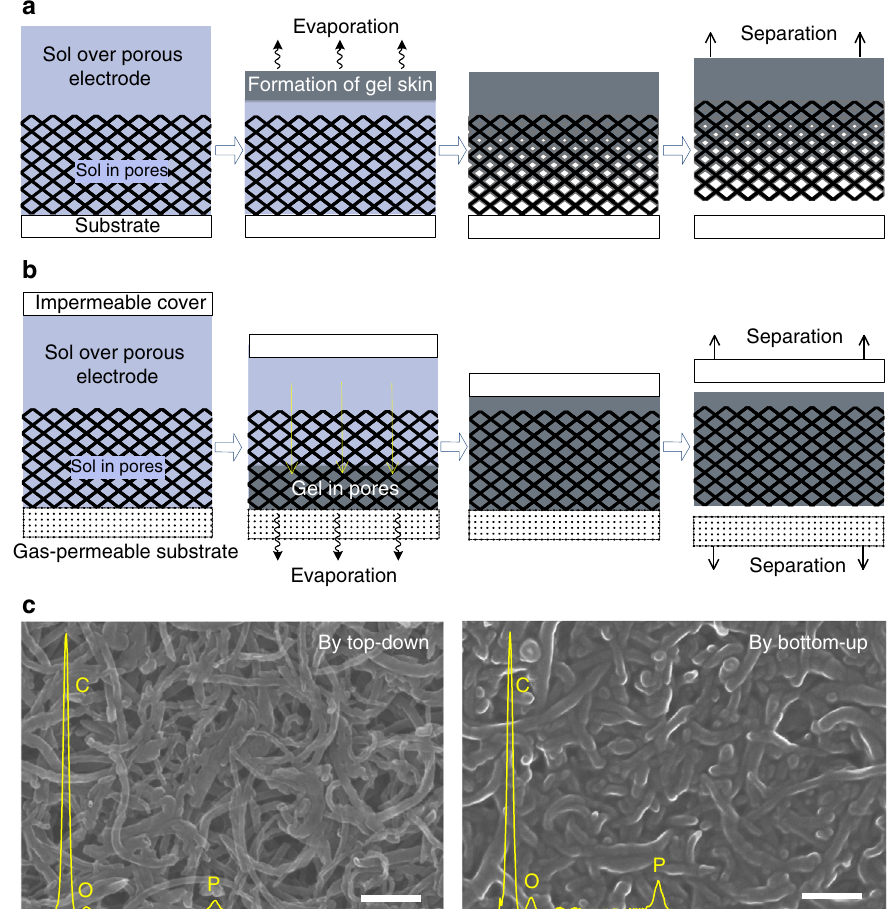
Fig. 1 Top-down vs bottom-up in fi lling. a The top-down in fi lling method. Left to right: sol is casted onto a porous electrode; sol above the porous electrode gels forming a skin; sol in the porous electrode gels, leaving behind voids; a free-standing incompletely fi lled electrode is obtained after the separation from the substrate. b The bottom-up in fi lling method. Left to right: sol is cast on a porous electrode located on a gas-permeable substrate and covered with an impermeable fi lm; the gel forms from the bottom-up until the entire porous electrode is in fi lled with gel; a free-standing gel- fi lled electrode is obtained after removal of the substrate. c SEM images of the top of the MWCNT electrodes in fi lled with gel electrolyte by the top-down (left) and bottom-up (right) methods. Overlaid on the images are energy dispersive spectroscopy scans where the phosphorus peaks indicate the presence of the electrolyte. Scale bar for c is 200